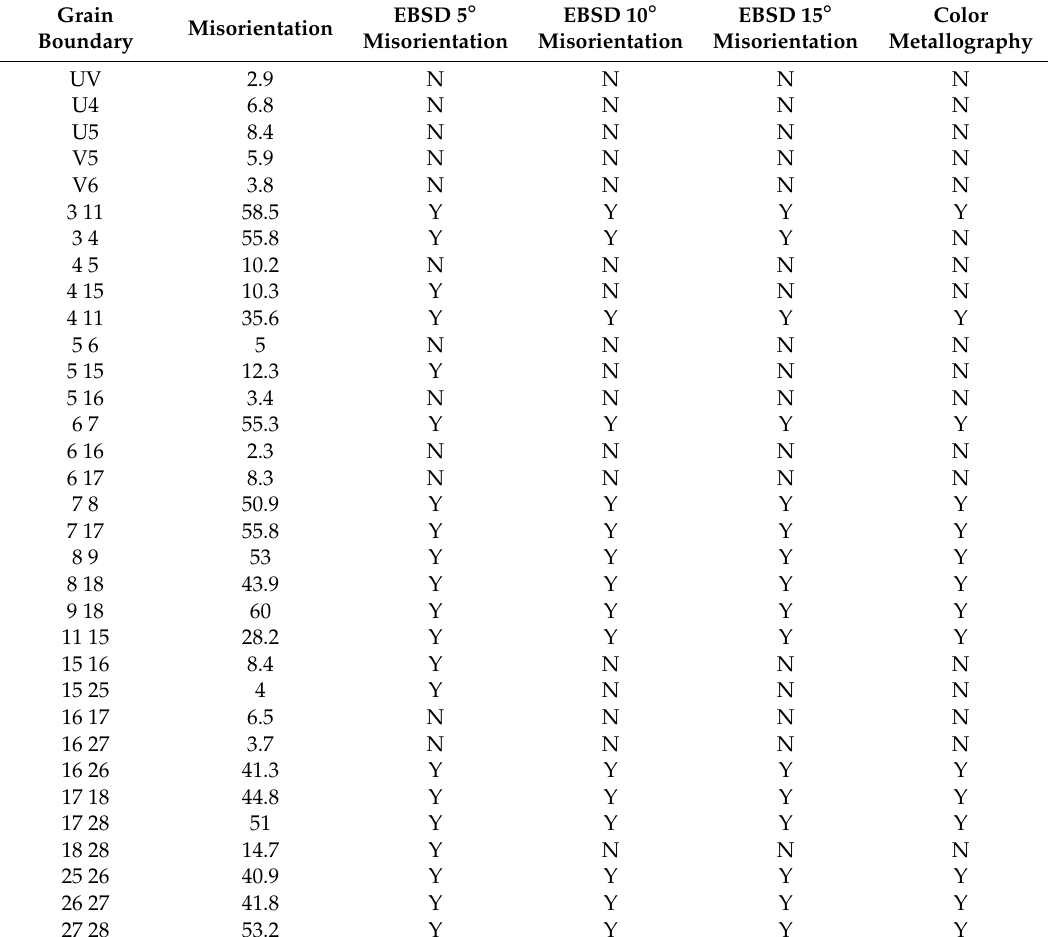
Table 4. EBSD data for as-cast EMS billets, sand mold, poured at 630 ◦ C (Y, Yes; N, No). EBSD 5 ◦ Color Grain Misorientation Boundary